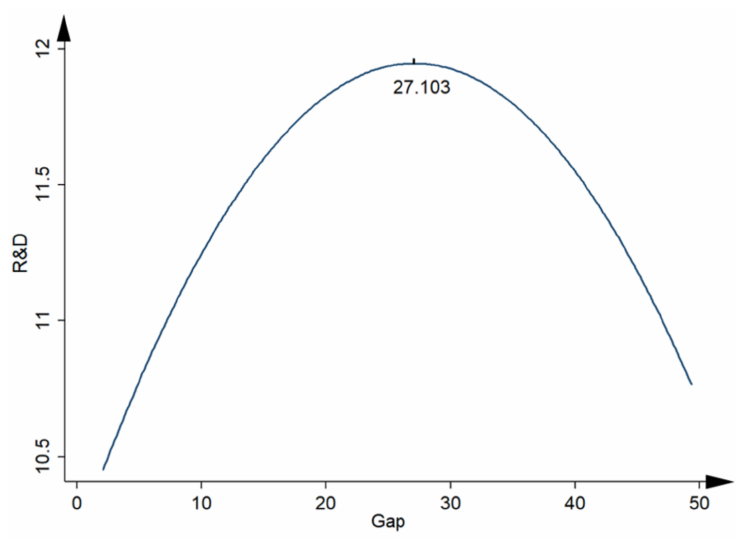
Figure 1. Inverted-U-shaped relationship between compensation gap and corporate innovation.